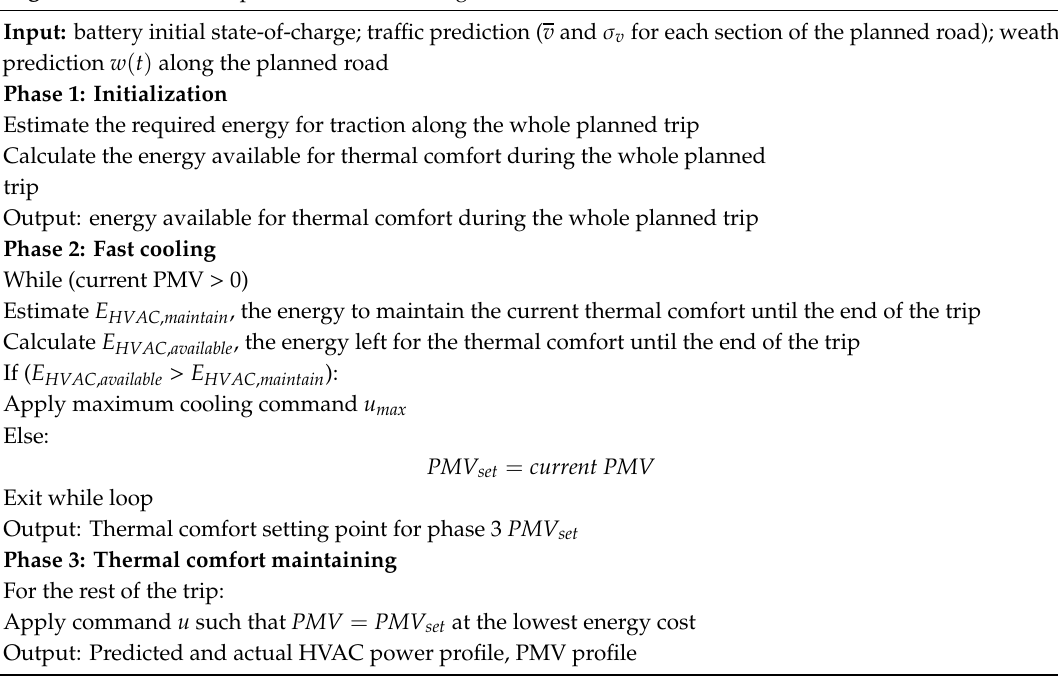
Algorithm 1. The main points of the TCMS algorithm are summarized